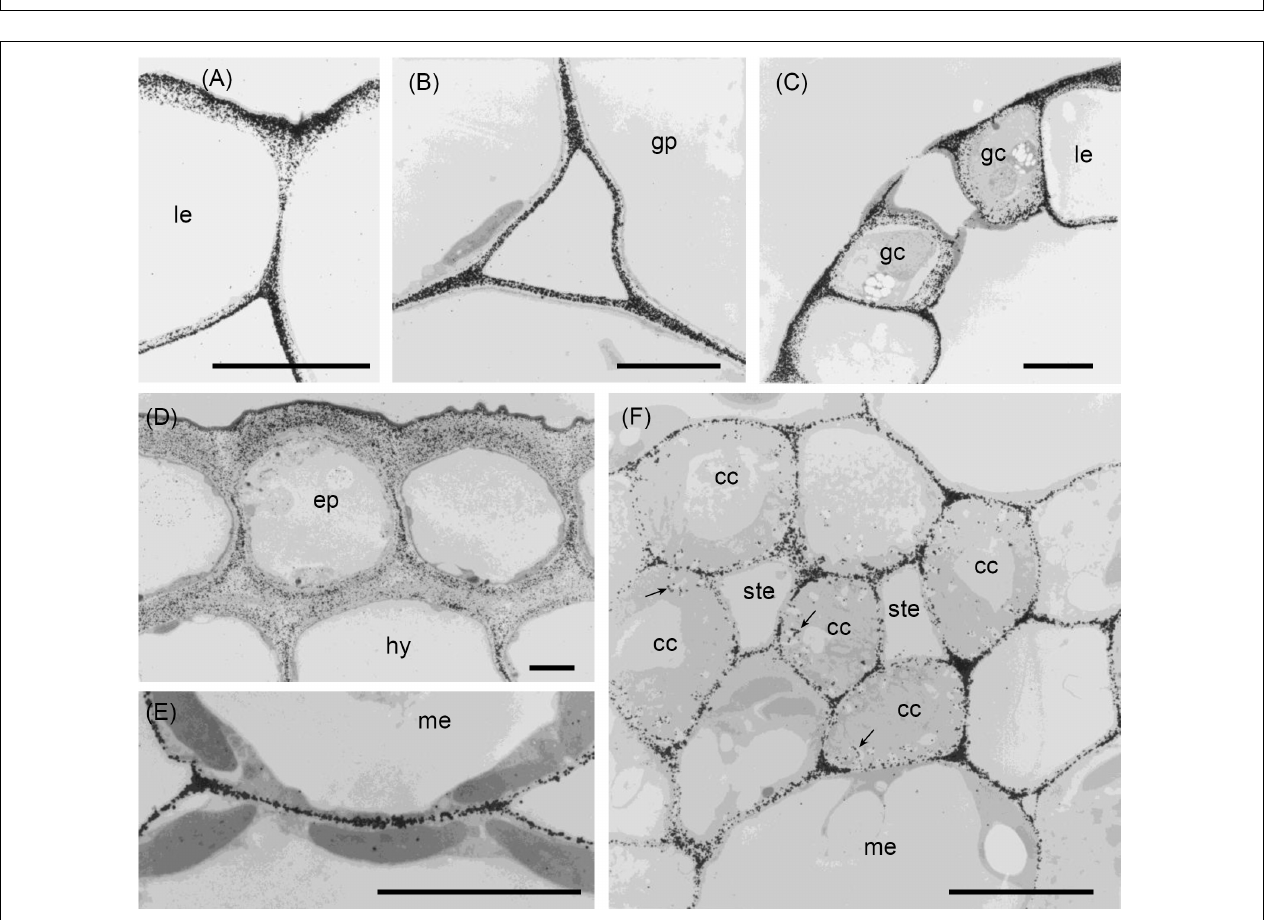
FIGURE 3 | walls of the stomatal guard cells. (H) The lamina labelled with LM6, showing intense labelling of the outer walls of the epidermal cells and the walls of the phloem transfer cells in a minor vein. (I) A minor vein in the lamina labelled with LM5, showing strong labelling of the walls and wall ingrowths of phloem companion cells (transfer cells). (J) The phloem in a midrib vascular bundle labelled with LM6, showing labelling of inclusions in some inner phloem cells. (K) The xylem in a midrib vascular bundle labelled with LM6, showing no labelling of the secondary walls of the tracheary elements but labelling of the primary walls of adjacent elements, and the walls of xylem ray parenchyma cells. (L) A minor vein in a lamina labelled with LM6, showing strong labelling of the walls and wall ingrowths of phloem transfer cells. cc: phloem transfer cell; ep: epidermal cell; gc: stomatal guard cell; hy: hypodermis; le: lamina epidermis; me: mesophyll; pf: phloem fibre; pp: phloem parenchyma; ste: sieve tube element; te: tracheary element; and xrp: xylem ray parenchyma. Bars: (A,B) 200 µ m; (C–H,J,K) 20 µ m; and (I,L) 5 µ m.